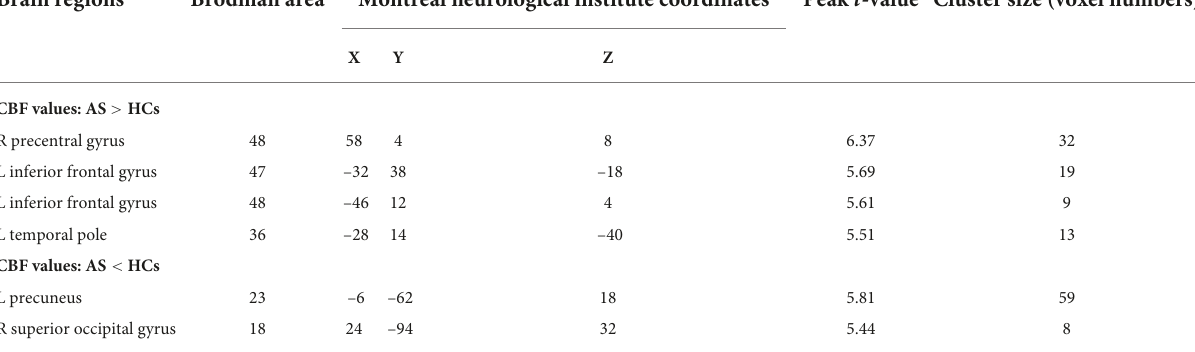
TABLE 2 The areas of significantly different CBF values between the AS patients and the HCs (voxel-level correction of FWE). Brain regions Brodman area